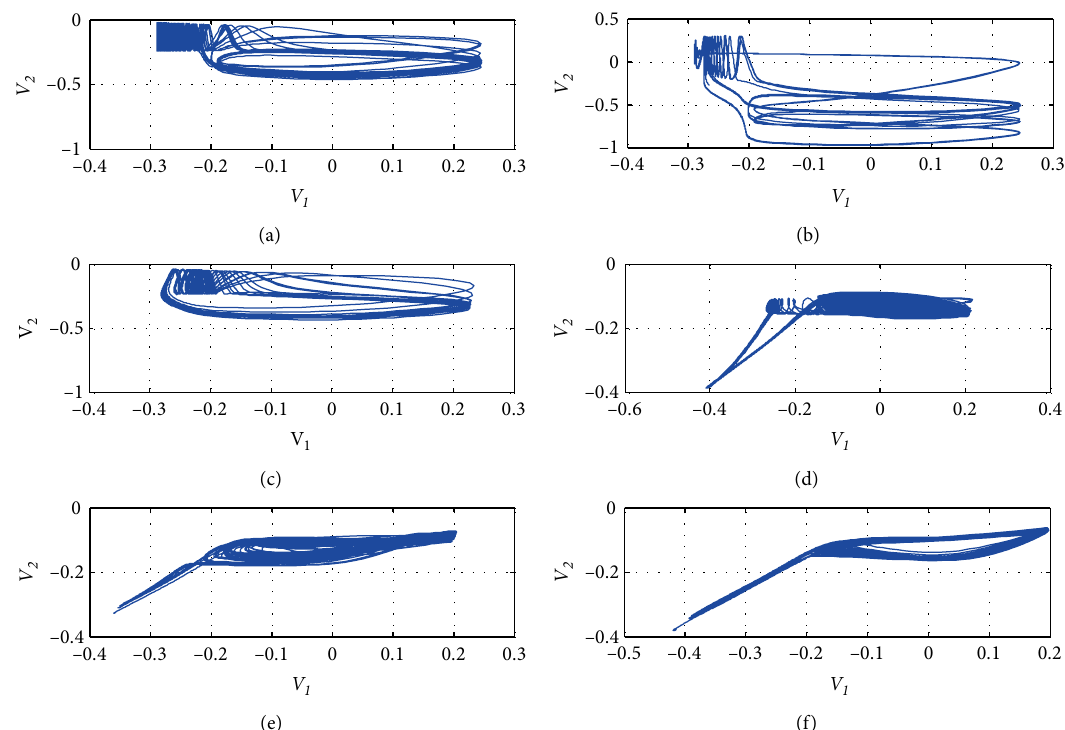
Figure 11: Phase diagrams of membrane potentials of two nonidentical coupled neurons with different coupling intensity values. (a) 𝑔 (b) 𝑔 , (c) 𝑔 , (d) 𝑔 , (e) 𝑔 , and (f) 𝑔 . Initial conditions are selected as (−0.1, 0, −2.5) and (−0.2, 0, −2.5) , 𝑠 = 0.03 𝑠 = 0.15 𝑠 = 0.5 𝑠 = 0.7 𝑠 = 0.9